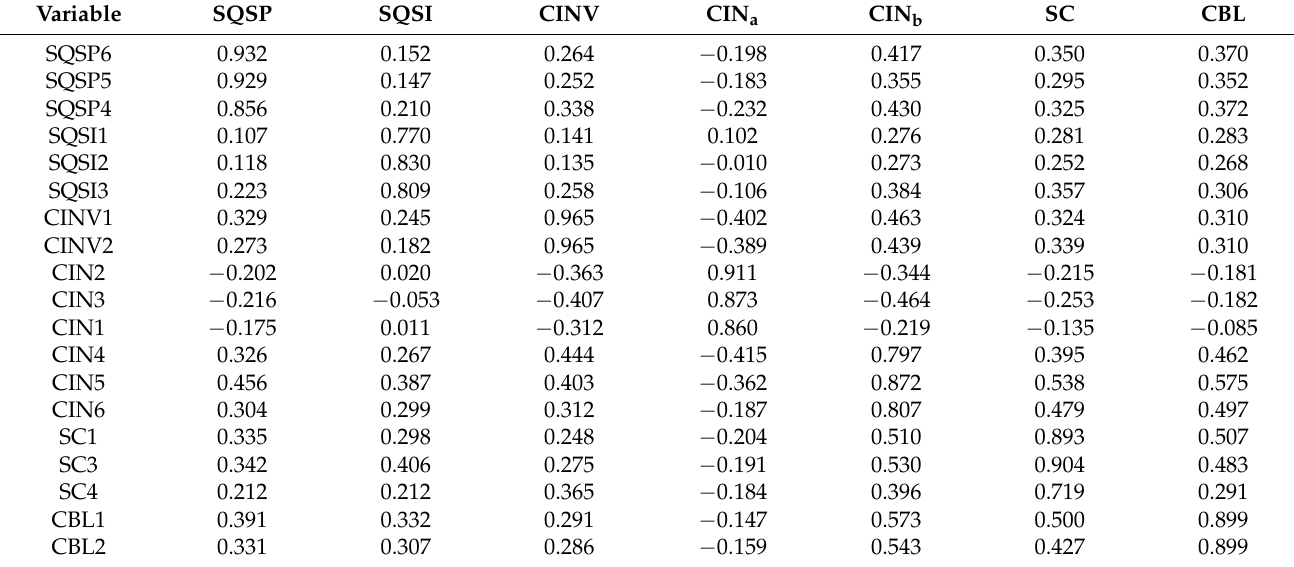
Table 8. Inter-item correlations of variable constructs.